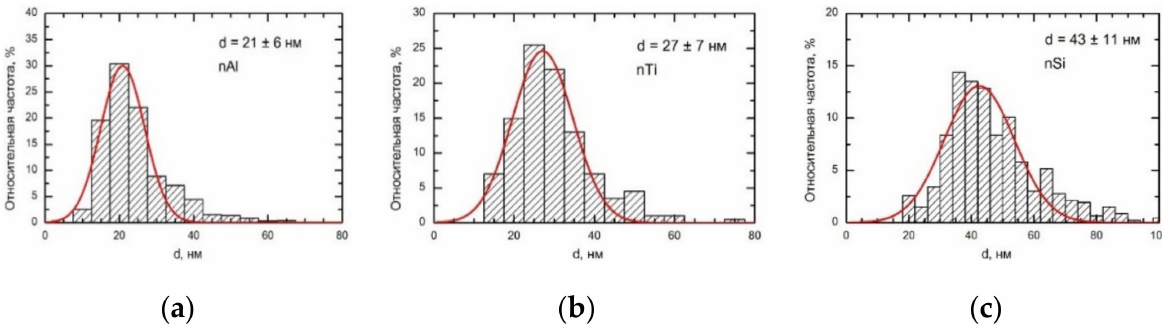
Figure 10. Size distribution of the nanoparticles used in the experiment (( a )—Al 2 O 3 ; ( b )—TiO 2 ; ( c )—SiO 2